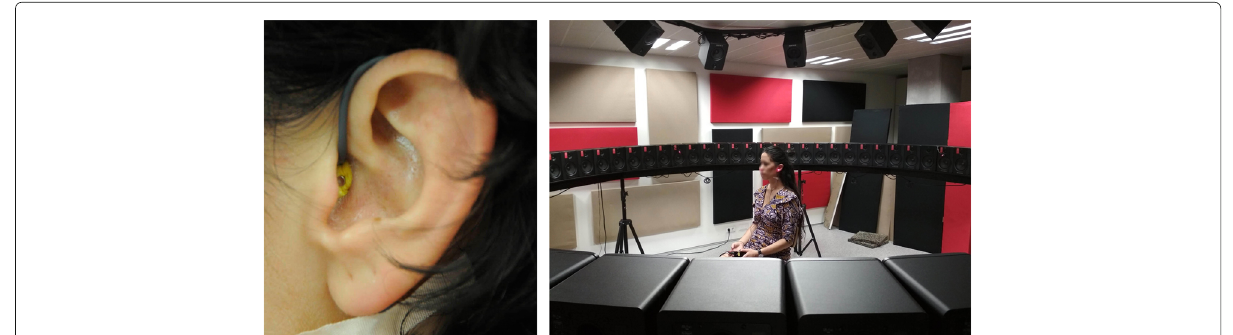
Fig. 1 Example of BRIR measurement and microphone inside the ear